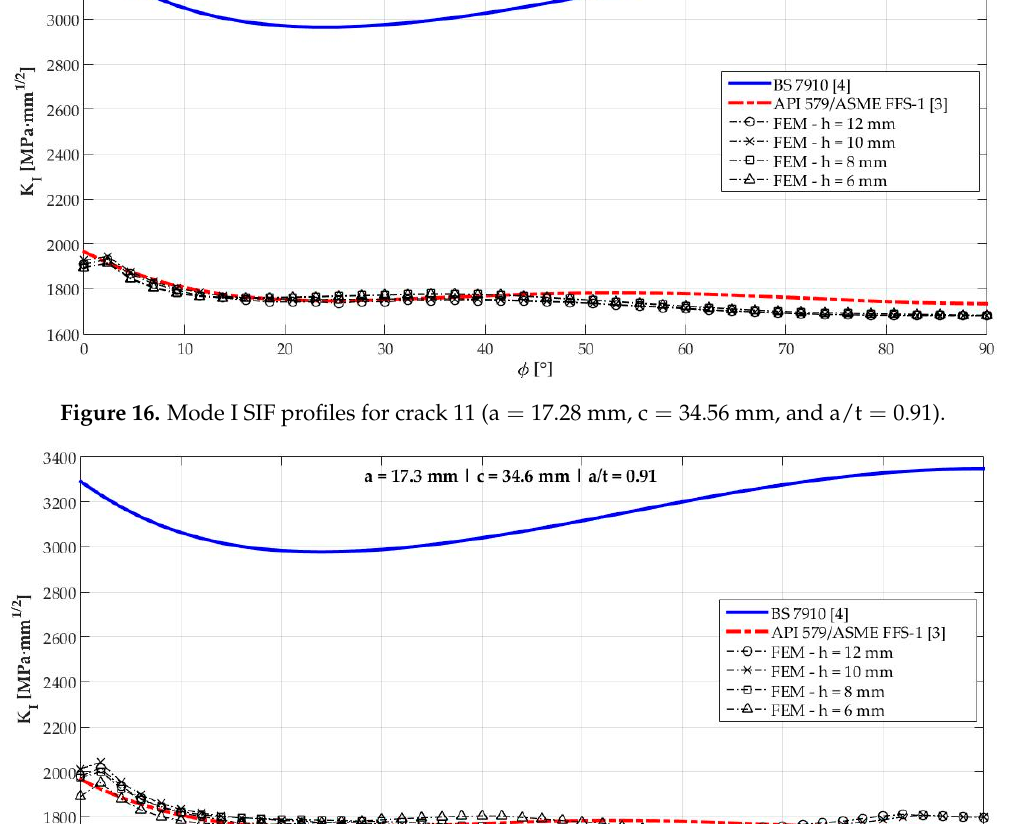
Table 5. Maximum mode I SIF values obtained from BS 7910 [4] and API 579/ASME FFS-1 [3] solutions and finite element method (FEM) results.